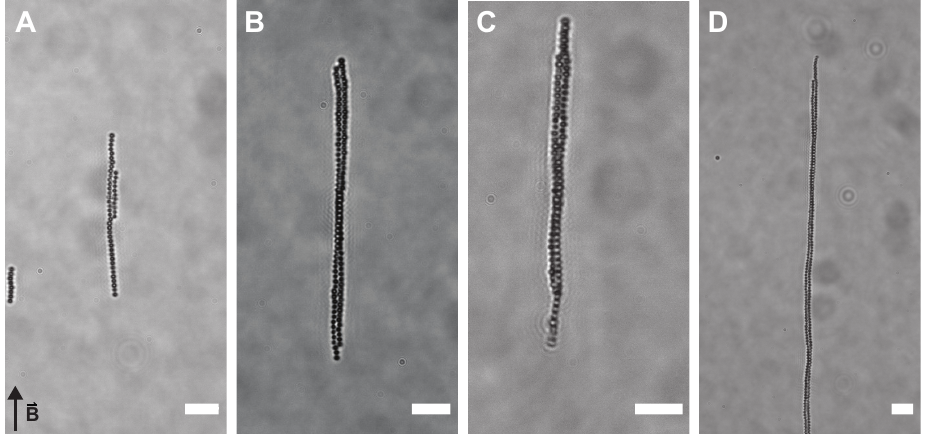
Figure 4. Helical sphere chains. In a homogeneous magnetic field of 1.4mT, long chains of spheres wind around each other forming helical chains in the presence of depletant. ( A ) 0mg/mL, ( B ) 0.10mg/mL, ( C ) 0.14mg/mL and ( D ) 0.16mg/mL PEO. Scale bars are 5 µ m. All images were taken approximately one hour after switching the magnetic field on. The arrow indicates the direction of the applied field in all